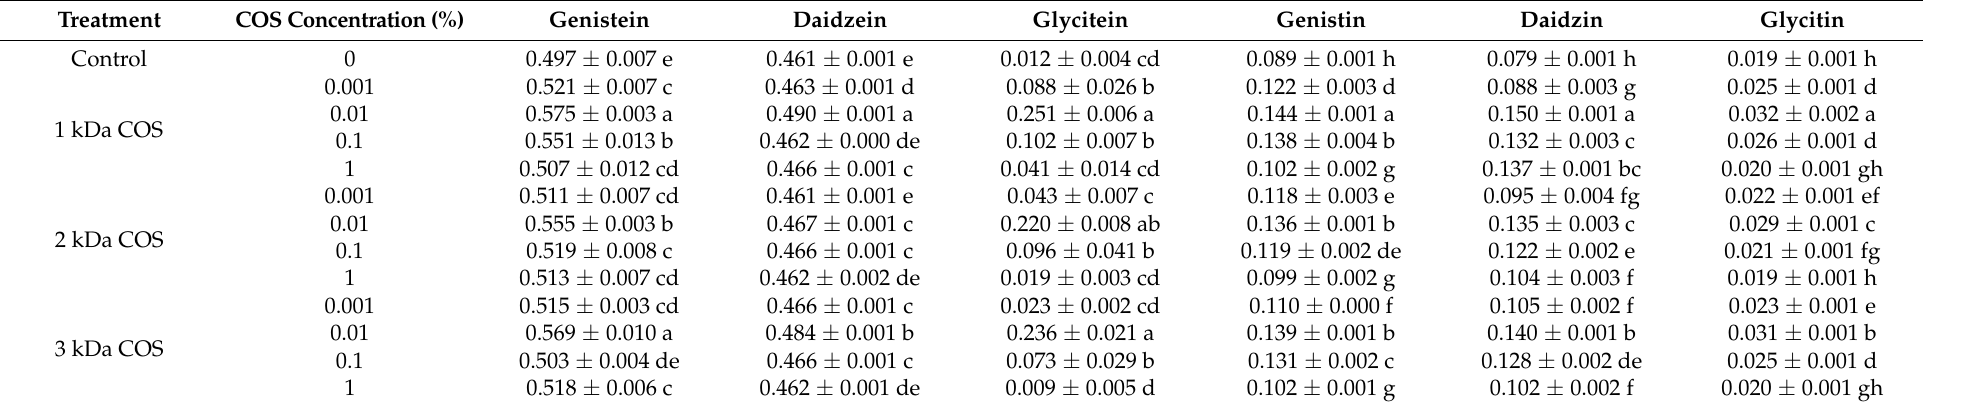
Table 2. Isoflavone components concentration (mg/g dry weight) of soybean sprouts under different chitooligosaccharide